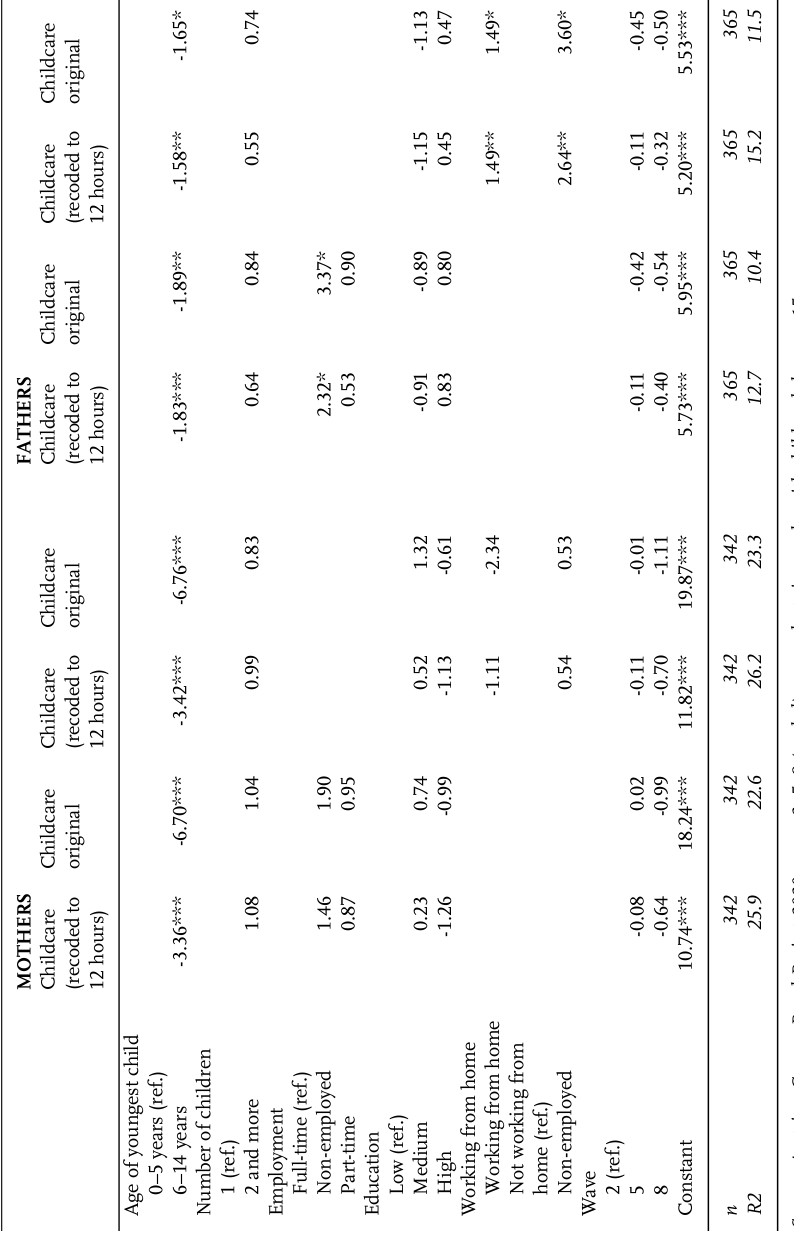
Table A7: Predictors of mean hours per weekday with childcare, April and May 2020, linear regression models; comparison of original childcare values and recoded to 12